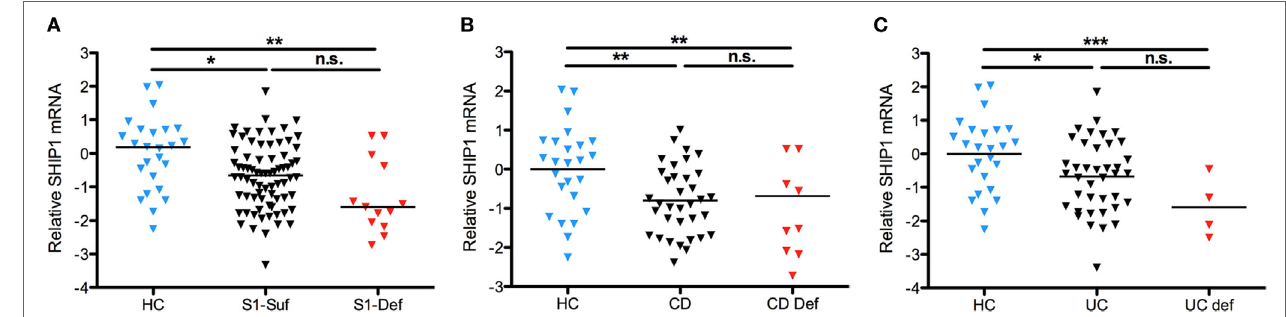
FigUre 3 | SHIP1 mRNA is reduced in both CD and ulcerative colitis (UC) as compared to healthy controls. (a) Log2 of SHIP1 mRNA levels relative to RPLP1 between healthy control (HC, n = 25) and either SHIP1-sufficient ( n = 74) or SHIP-deficient ( n = 13) IBD subjects. (B,c) Log2 Relative SHIP1 mRNA levels were not significantly different between SHIP1-Sufficient CD (CD Suf n = 34) or SHIP1-Deficient CD (CD Def, n = 9) subjects (B) nor between SHIP1-Sufficient UC (UC Suf n = 40) or SHIP1-Deficient UC subjects (UC Def, n = 4) (c) although they were all significantly reduced as compared to healthy controls (two-tailed t -test with Welch’s correction for unequal variances, * P < 0.05, ** P < 0.01, *** P <